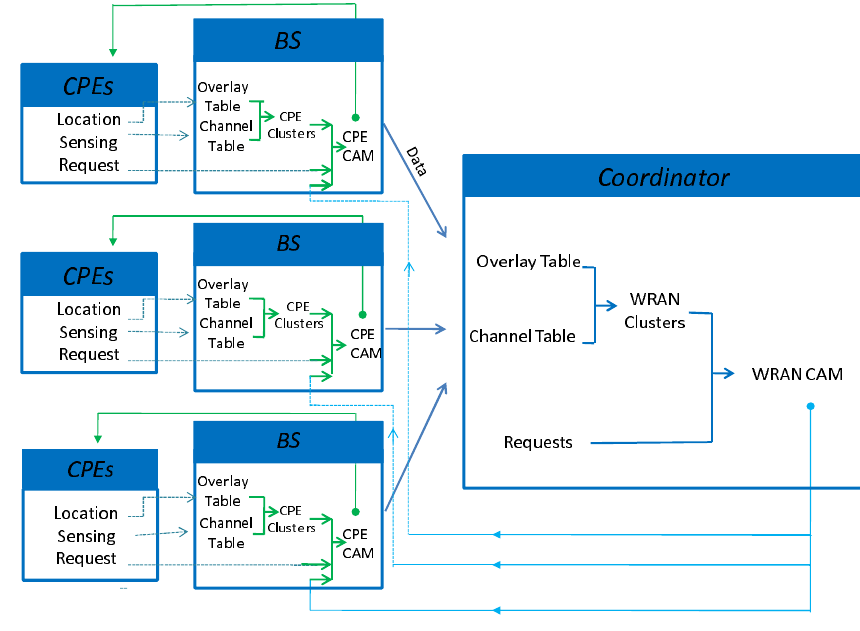
Figure 2. 2I-RSA